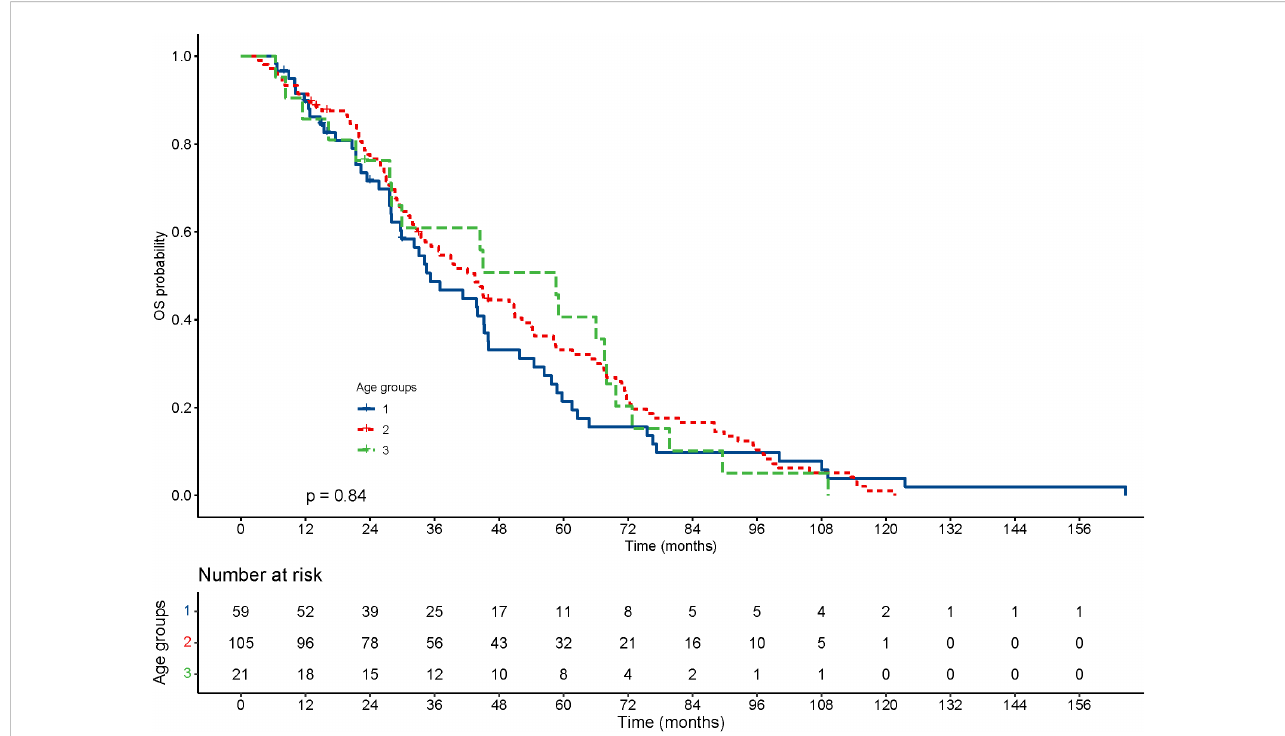
FIGURE 2 Kaplan – Meier curves for overall survival (OS) of patients with small hepatocellular carcinomas after cryoablation. The log-rank test showed no signi fi cant difference between the four groups